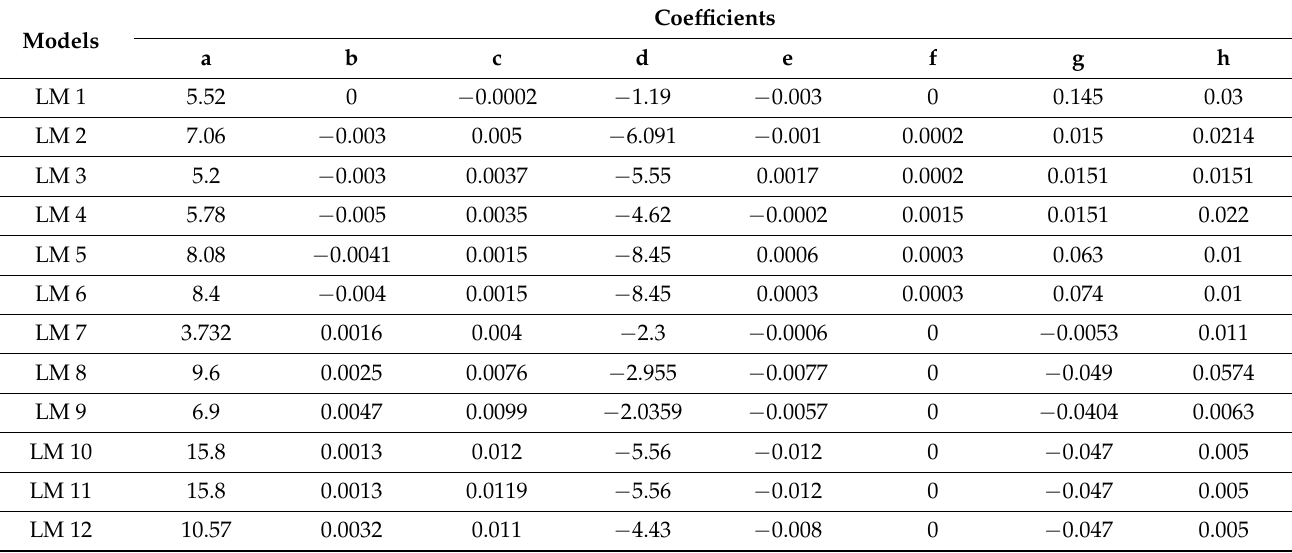
Figure 14. Generated model tree structure of M5P II. Table 5. Coefficients of linear models developed by M5P II based on Equation (3).